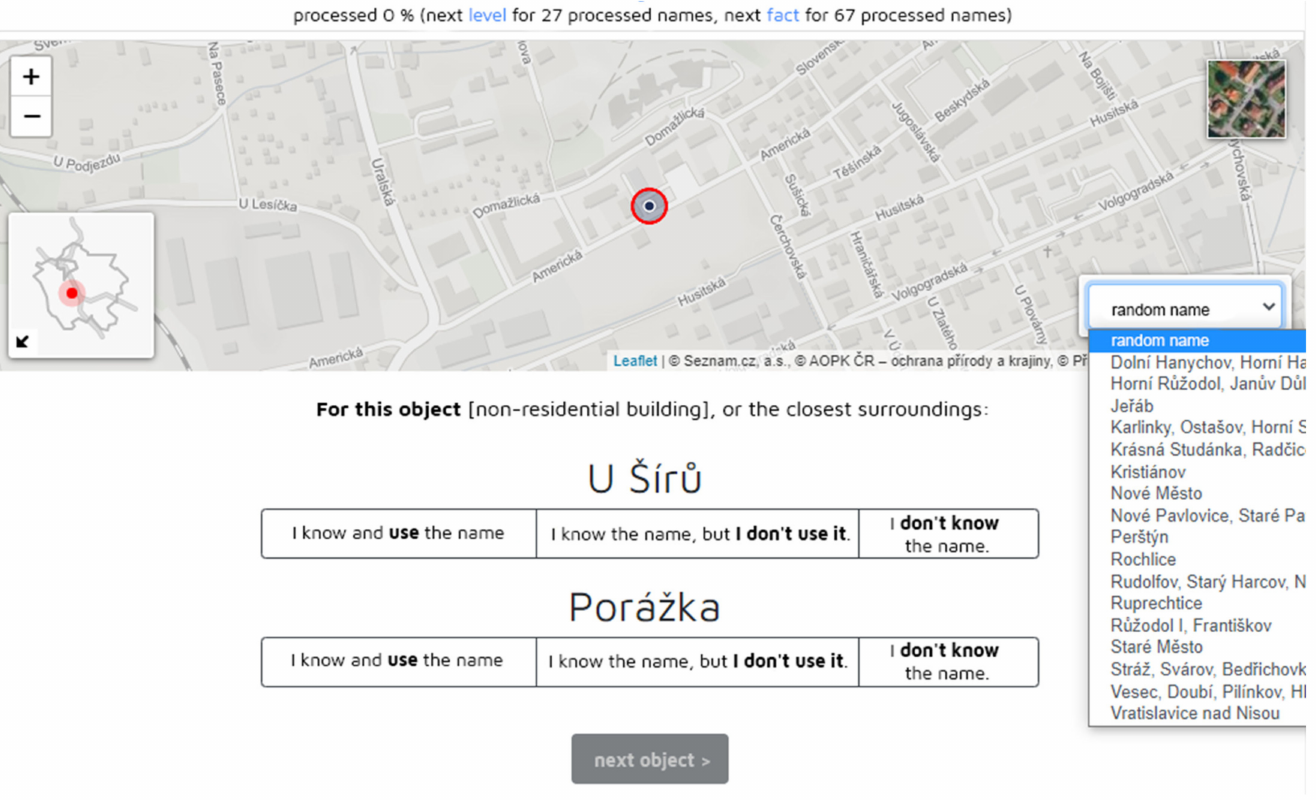
Figure 5. A part of the layout of the desktop version of the application, second phase. The heading and the bottom of the page is missing as it is the same as in the application used in the first phase. The application is developed in the Czech language. For the demo version, refer to https://mapy.fp.tul.cz/app/zj-demo/znalost/ (accessed on 5 May